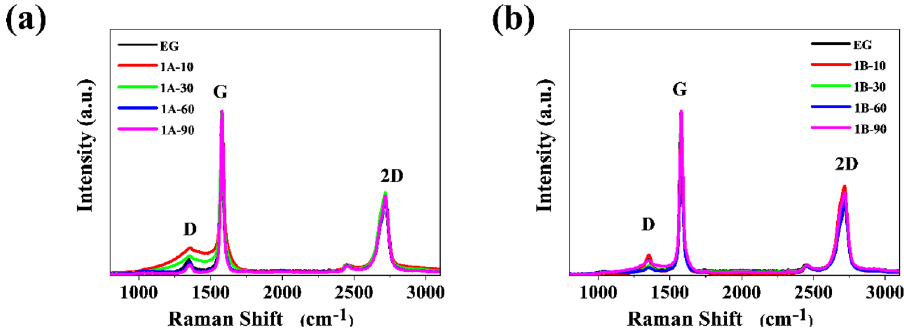
Figure 4. Raman spectra of ( a ) 1A-T and ( b ) 1B-T series compared to pristine EG.